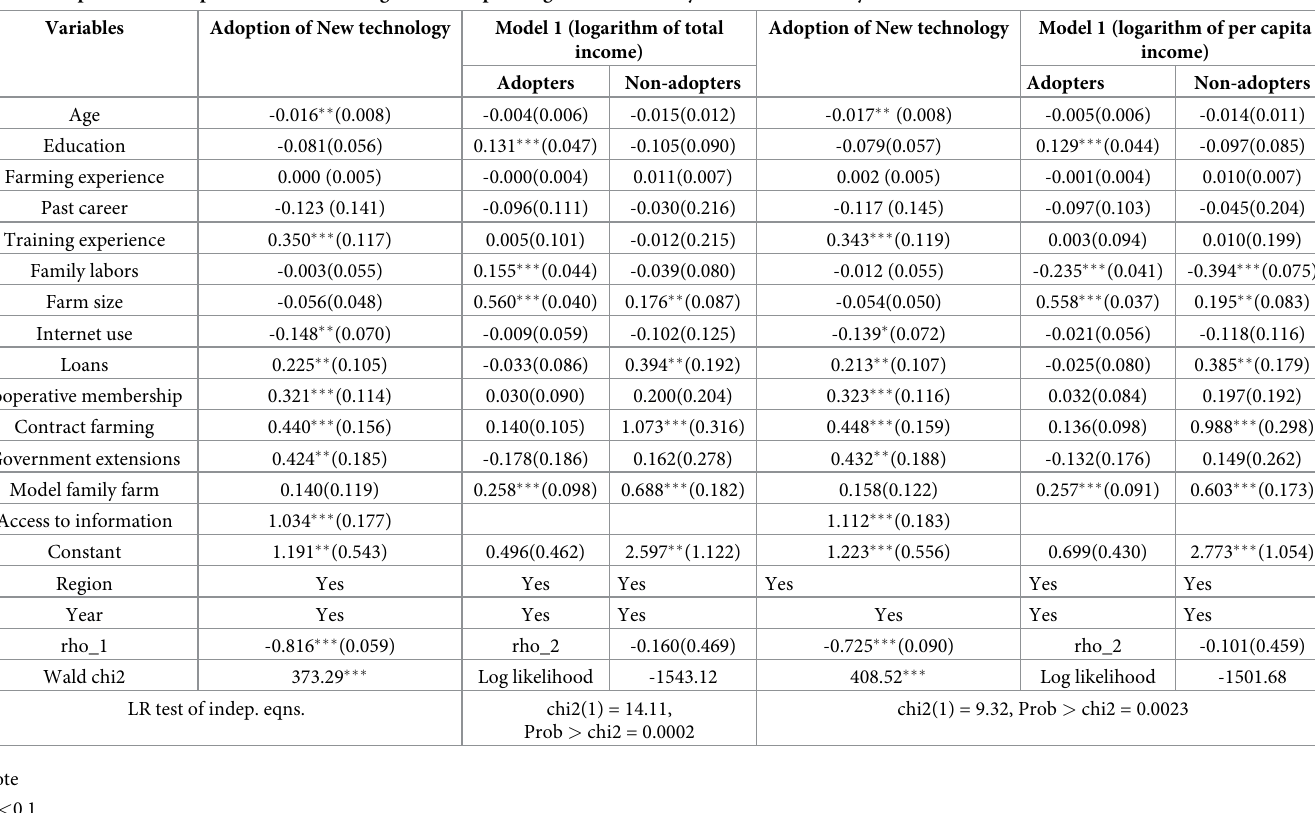
Table 6. Impact of the adoption of new technologies on the operating income of family farms: Estimated by the ESR model.